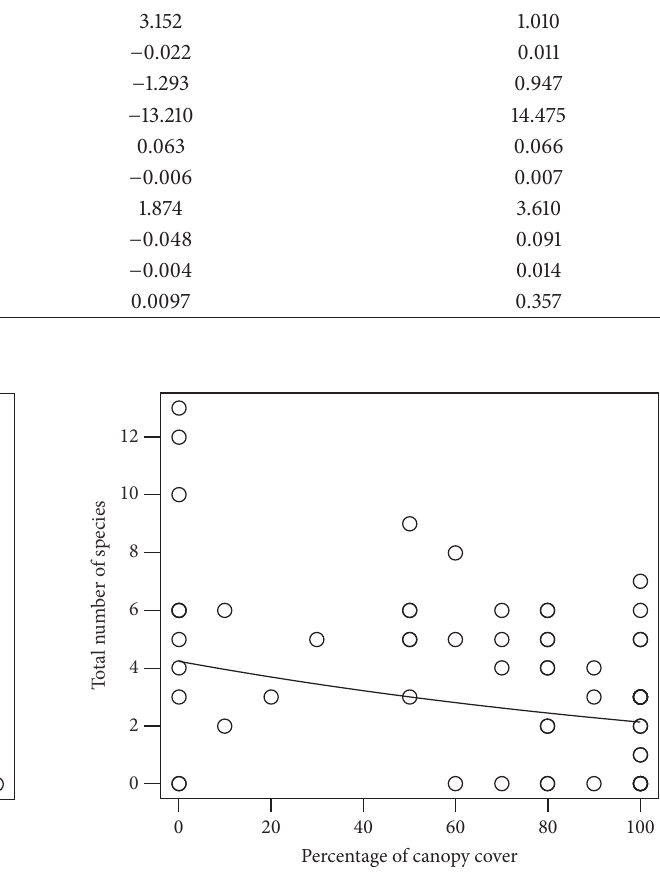
Figure 3: Prediction of species richness in relation to PO 4 concen- tration based on the coefficients of the best models selected by AIC stepwise selection.